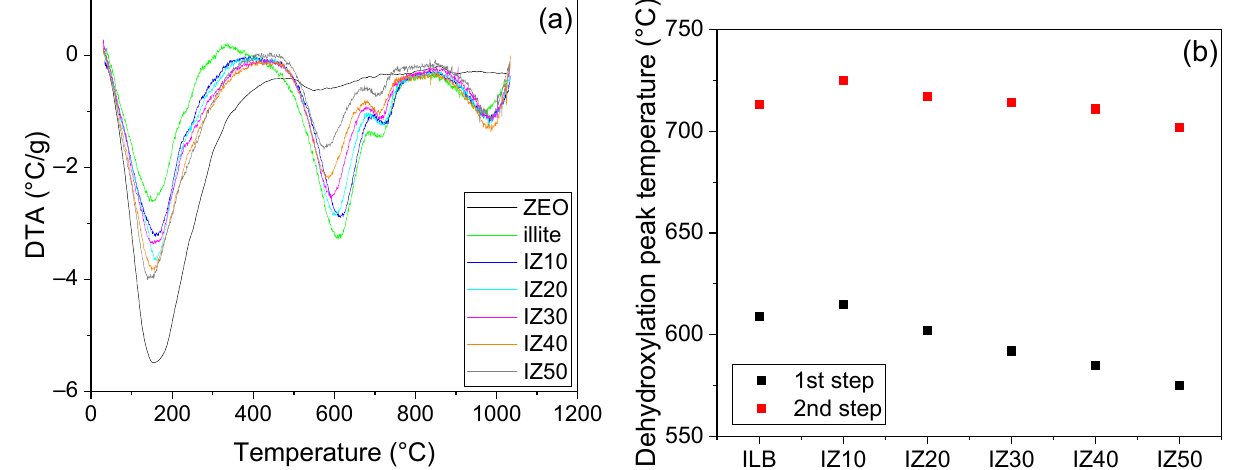
Figure 1. Differential thermal analysis of the samples ( a ). Peak temperatures of the illite dehydroxy- lation (1st and 2nd step) ( b ).